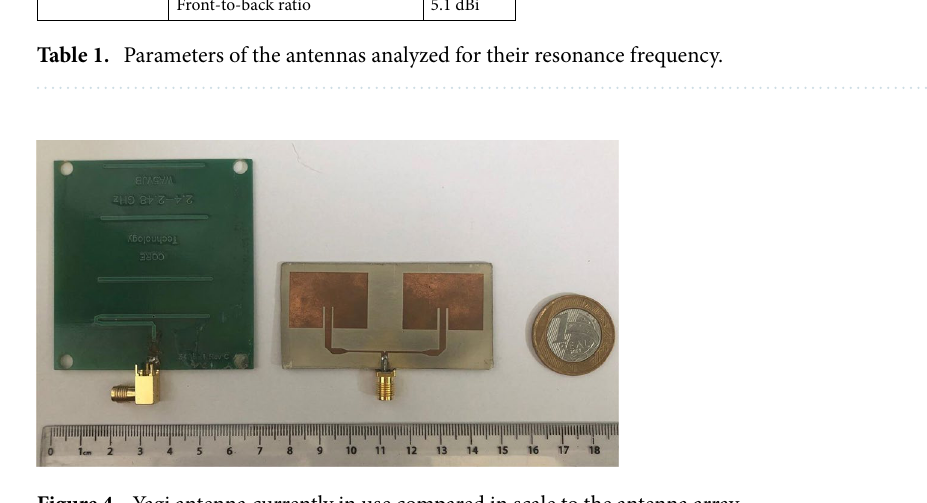
Figure 4. Yagi antenna currently in use compared in scale to the antenna